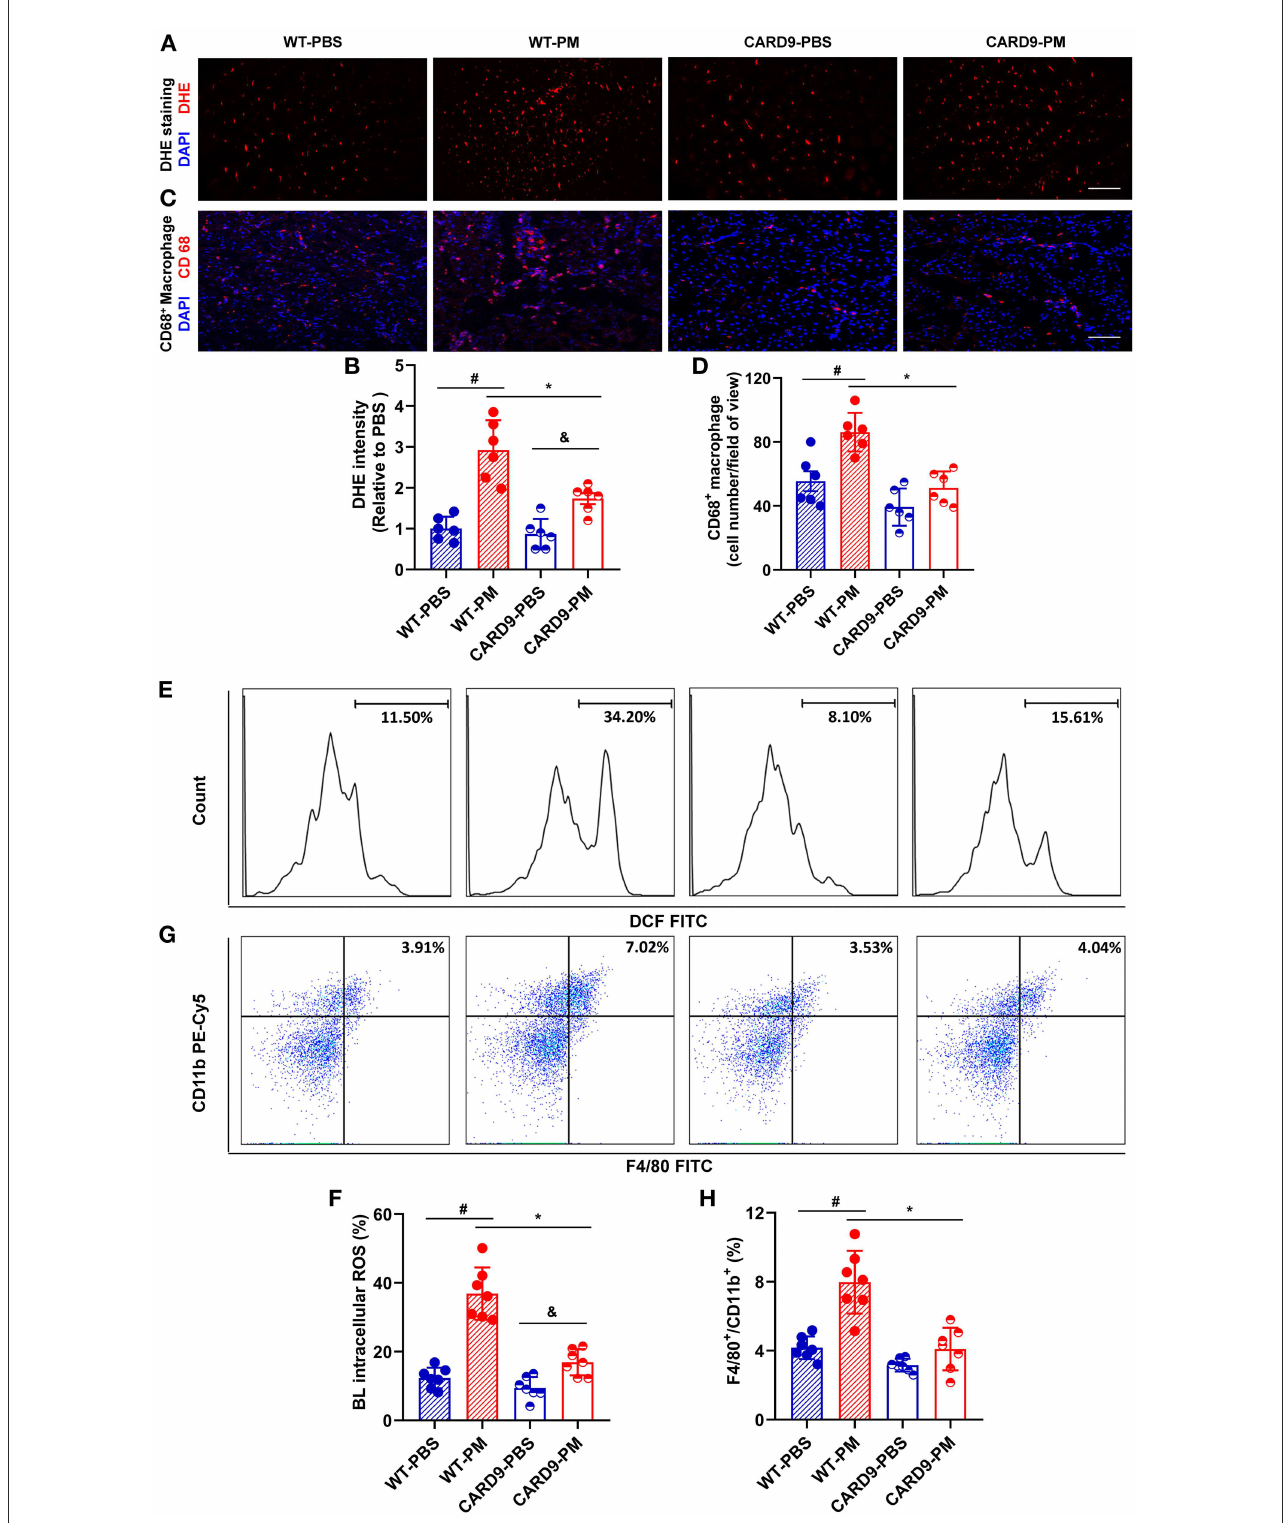
FIGURE4 CARD9 deficiency effectively prevented PM-induced increase of ROS production and macrophage infiltration in ischemic limbs. Immunostaining and flow cytometry analysis demonstrated that PM-induced increases in the levels of ROS and macrophages/monocytes in blood and ischemic limbs were significantly attenuated in CARD9 deficient mice [* p < 0.01 for WT-PM vs. CARD9-PM; # p < 0.01 for WT-PBS vs. WT-PM; & p < 0.05 for CARD9-PBS vs. CARD9-PM, (A–H) ]. DAPI, 4 ′ ,6-diamidino-2-phenylindole; DHE, dihydroethidium; BL, blood; Scale bar, 50 µ m. n = 6/group. Statistical differences were determined by one-way ANOVA with Tukey’s post-hoc